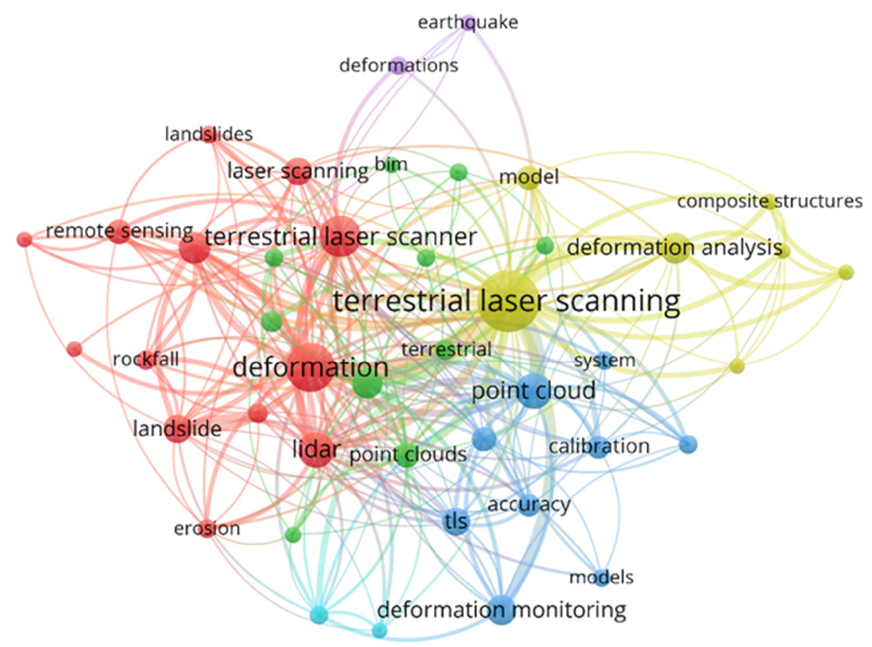
Figure 1. Network of co-occurring keywords.